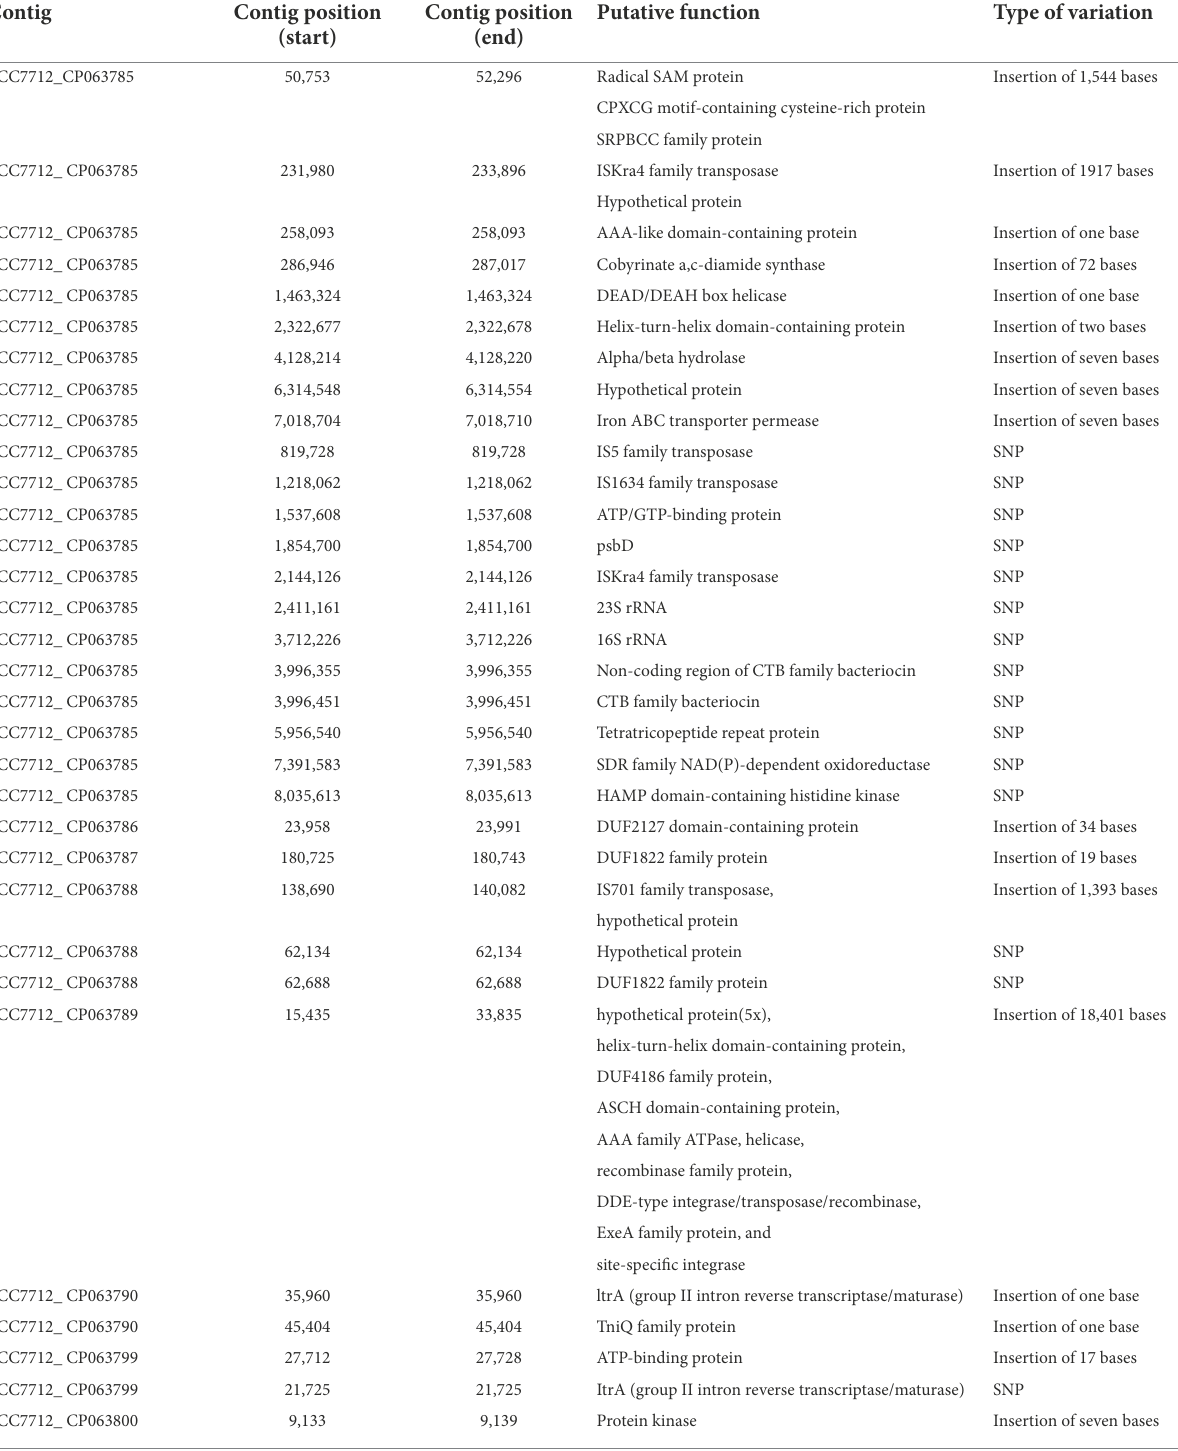
TABLE 3 Examples of SNPs and insertions found in the genome of PCC 7712 compared to PCC 7601. For a complete list please refer to Supplementary Excel File S1.